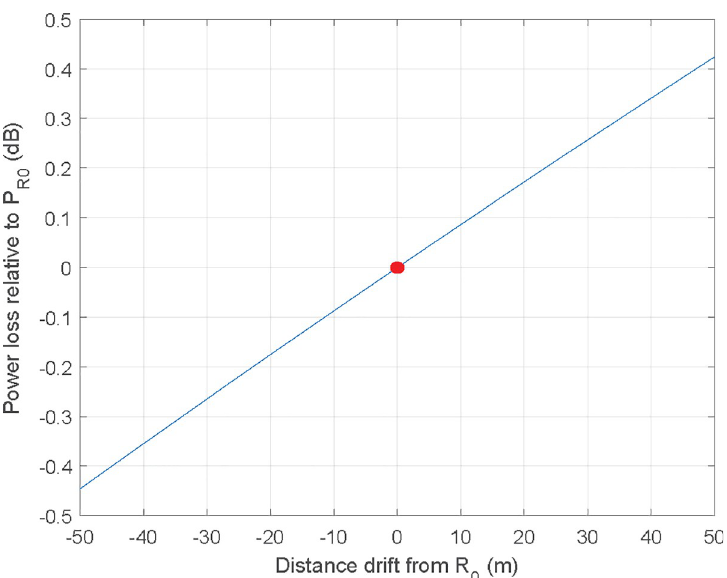
Fig 2. Correction factor that should be applied to the estimated gain if radial distance deviation from the theoretical path exists.